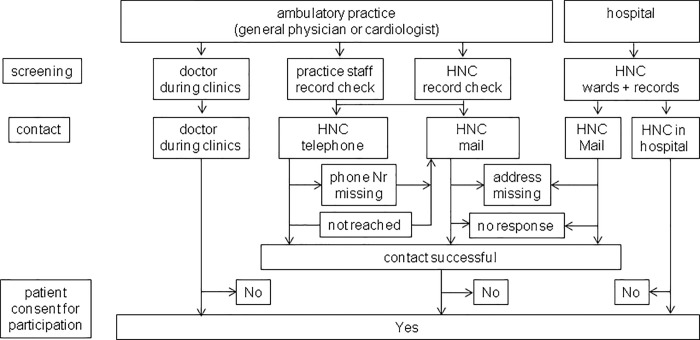
Pathways for screening and contacting patients for participation in the heart failure management programme.HNC indicates staff of the programme.